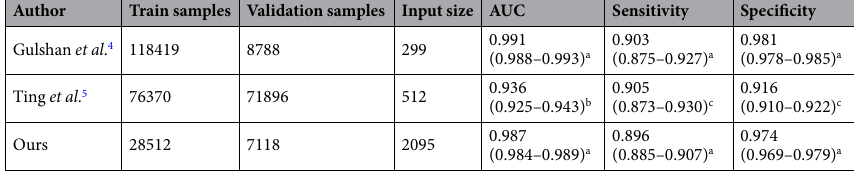
Table 2. Comparison of classification results for referable diabetic retinopathy. The train and validation samples refer to the image amounts in the respective sets, and the input size refers to the image width and height in pixels. Tuning set is included in the train sample size. Our operating point for sensitivity and specificity is calculated at 0.900 sensitivity for comparison of results at similar operating point to Gulshan et al . 4 and Ting et al . 5 . a 95% exact CI calculated with Clopper-Pearson method. b 95% asymptotic, bias-corrected CI calculated with cluster-bootstrap on patient level. c 95% asymptotic CI calculated for each logit with cluster sandwich using on patient